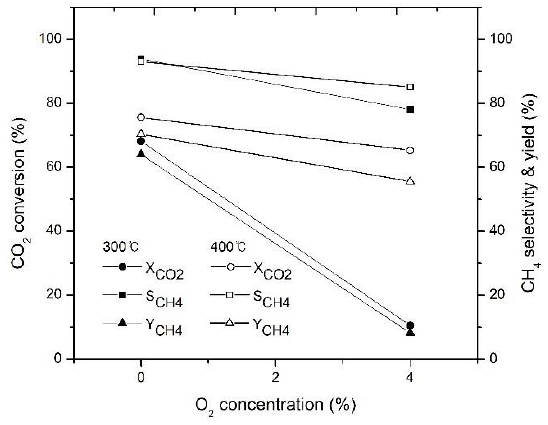
Figure 7. Effect of O 2 in reaction gas.